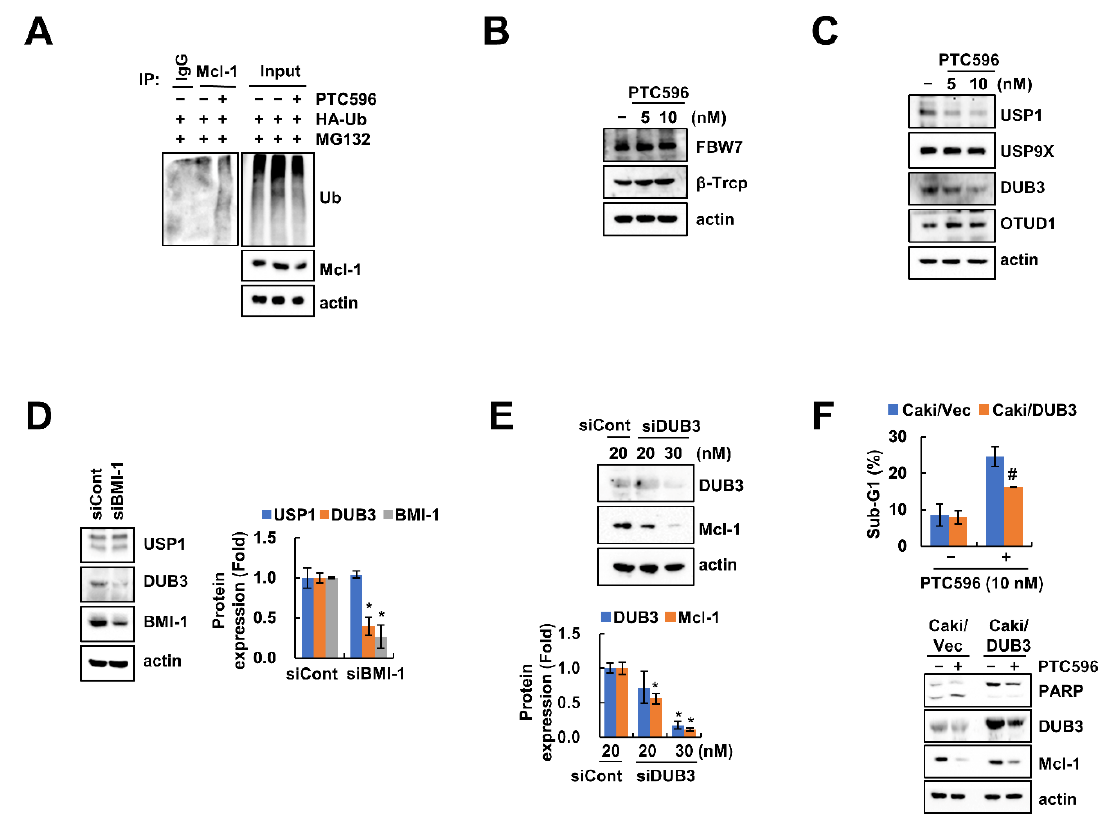
Figure 4. Downregulation of DUB3 is associated with PTC596-induced Mcl-1 downregulation and apoptosis. ( A ) Caki cells were transfected with HA-ubiqutin (HA-Ub) plasmid and treated with MG132 (0.5 μM) and PTC596 (10 nM). Mcl-1 ubiquitination was detected by Western blotting using HRP-conjugated anti-Ub antibody; ( B , C ) Caki cells were treated with PTC596 (5, 10 nM) for 24 h; ( D – E ) Caki cells were transfected with Cont, BMI-1 ( D ) or DUB3 siRNA ( E ) for 24 h; ( F ) Caki cells were transfected with Caki/Vec or Caki/DUB3 plasmids and then treated with PTC596 (10 nM) for 24 h. The sub-G1 population and protein expression were measured by flow cytometry ( F ) and Western blotting ( A – F ). The band intensity was examined using Image J ( D , E ). * p < 0.01 compared to the control siRNA. # p < 0.05 compared to the PTC596 in Caki/Vec cells.